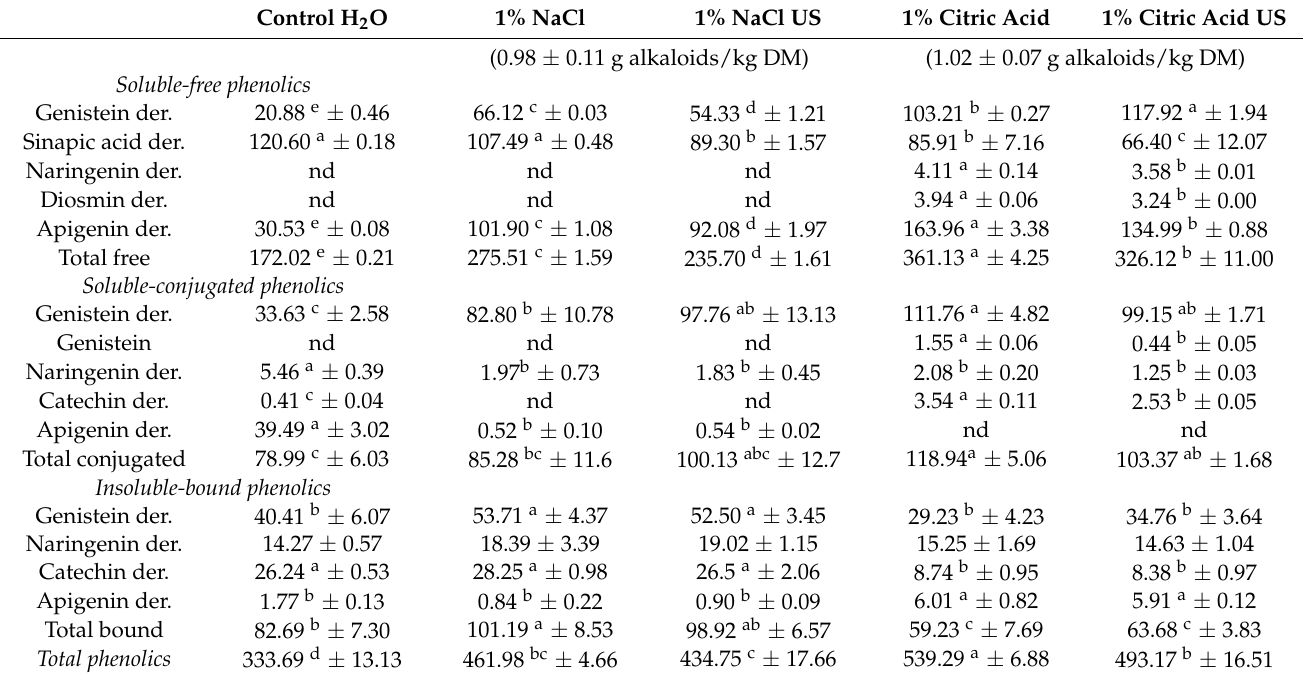
Table 2. Phenolic content (mg/kg DM; mean ± standard deviation) in Lupinus albus seeds (Lot 1) after debittering by the control method with water (Erba¸s [28], modified by C ó rdova-Ramos et al., [27]) and by the method proposed by Estivi et al. [25], without and with ultrasound (US), and with